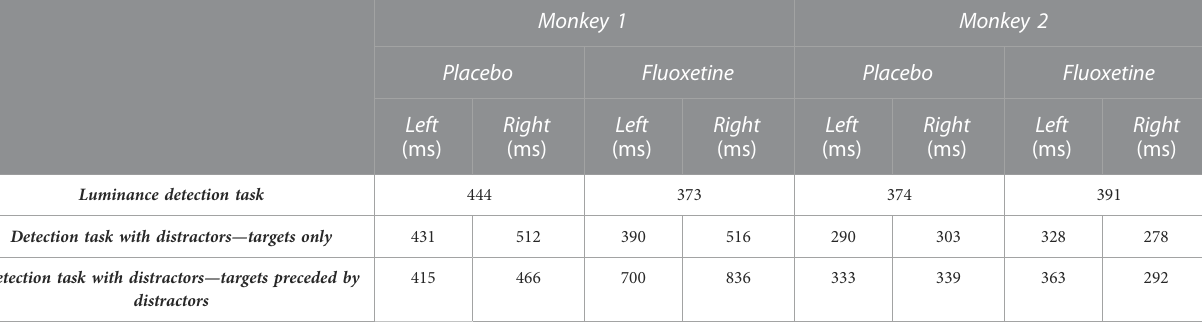
TABLE2RTthresholdbetweenanticipatoryandcontrolledresponsesasde fi nedbytheLATERmodel.Thisthreshold wasde fi nedindependentlyforeachmonkey, each task and each target position, except for the luminance detection task, for which all four positions were considered